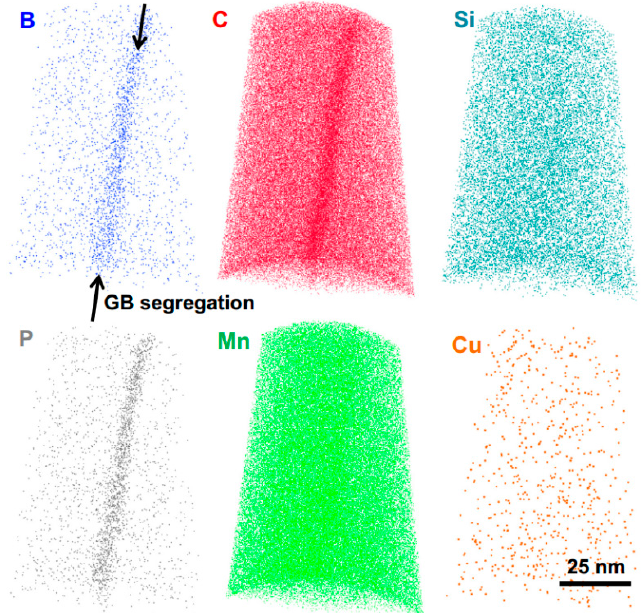
Figure 9. Element segregation on grain boundaries in 3D elemental atom maps (Reprinted with permission from Ref. [17], Copyright 2022 Elsevier).